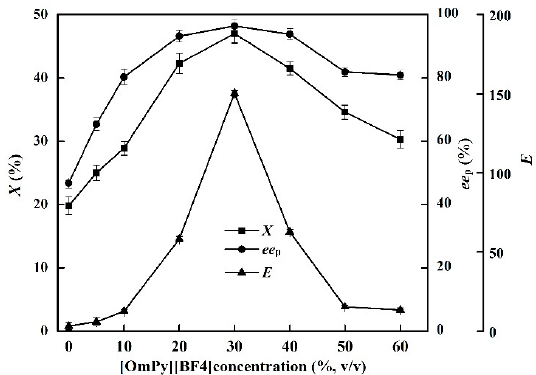
Figure 1. Effect of IL concentrations on the conversion degree, enantiomeric excess of product and enantioselectivity of EST10 using [OmPy][BF 4 ] as a co-solvent in the presence of enzyme EST10 (15 mg/mL) at 75 ˝ C for 10 h. The concentration of racemic ibuprofen ethyl ester was 2.5 mg/mL. The values are means of three independent